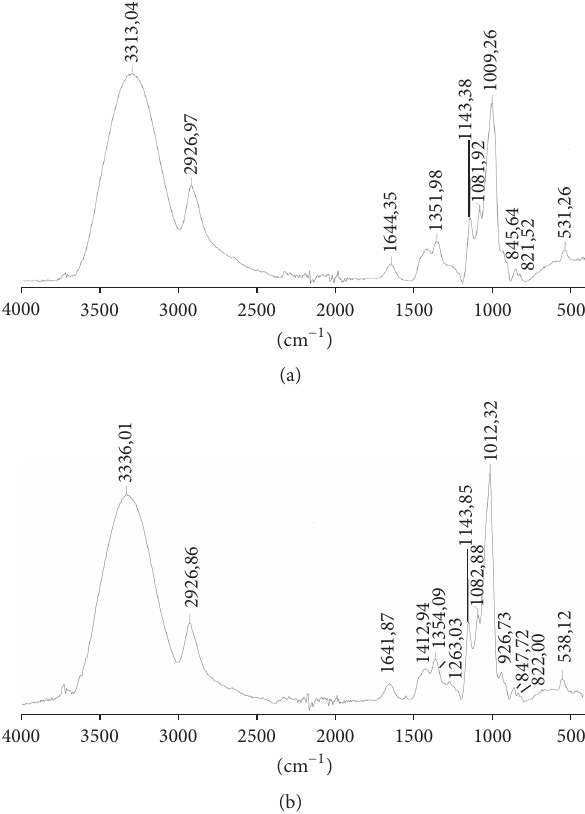
Figure 3: FT-IR spectra of alkali-soluble water-insoluble polysac- charides (ASPs) obtained from fruiting body (a) and vegetative mycelium (b) of C. unicolor